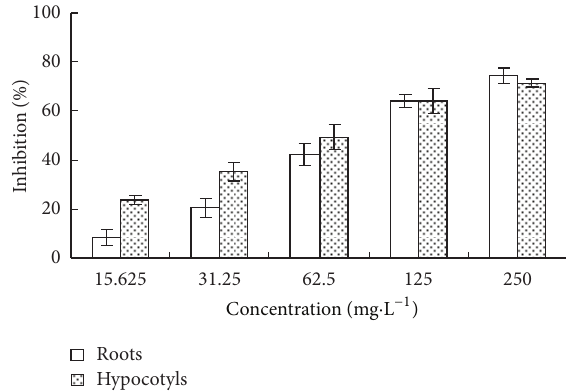
Figure 2: 13 C-NMR spectra of 5-fluoro-2-hydroxy butyrophenone. Table 1: Antifungal activity of 5-fluoro-2-hydroxy butyrophenone against six plant pathogenic fungi.